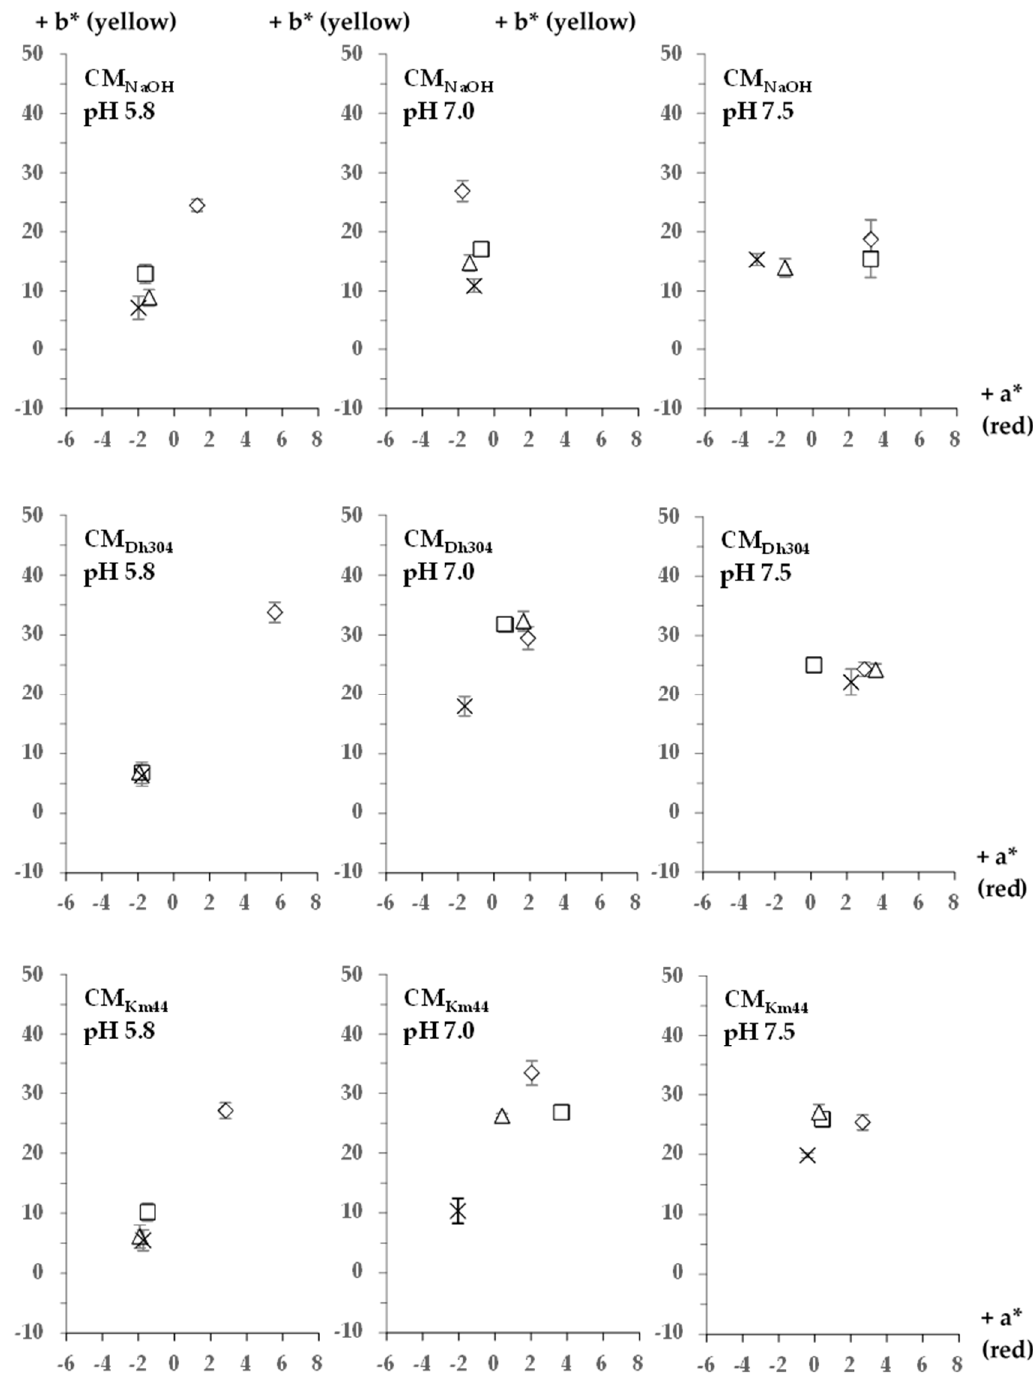
Figure 2. Detailed positions of Arthrobacter arilaitensis Po102 cultures when projected in the CIE L*a*b* colorimetric scale (bars indicate standard deviations) after day (d) 28 incubation. The concentration of additional NaCl (w/v) is presented in colors as follows: 0% ( ), 2% ( ), 4% ( ), and 8% ( ).